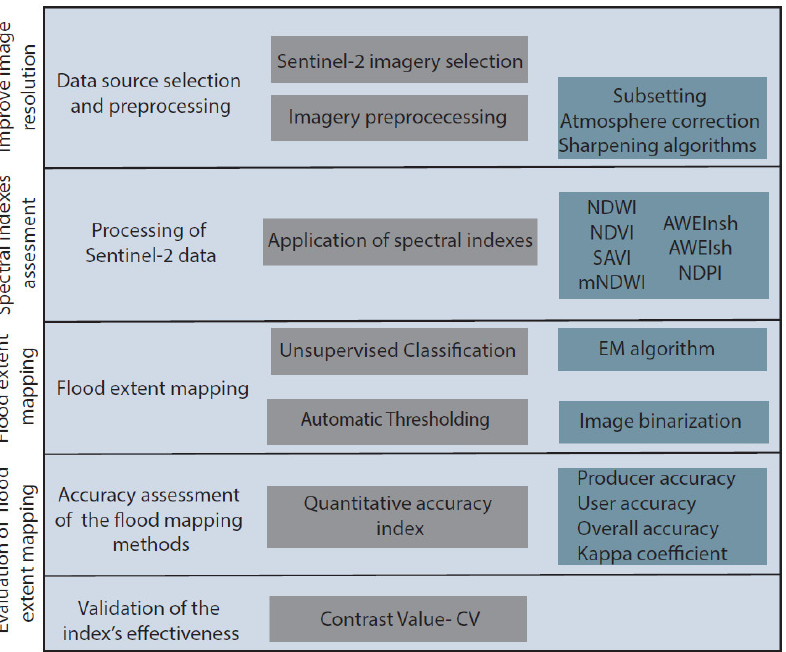
Figure 1. Methodology of the study.